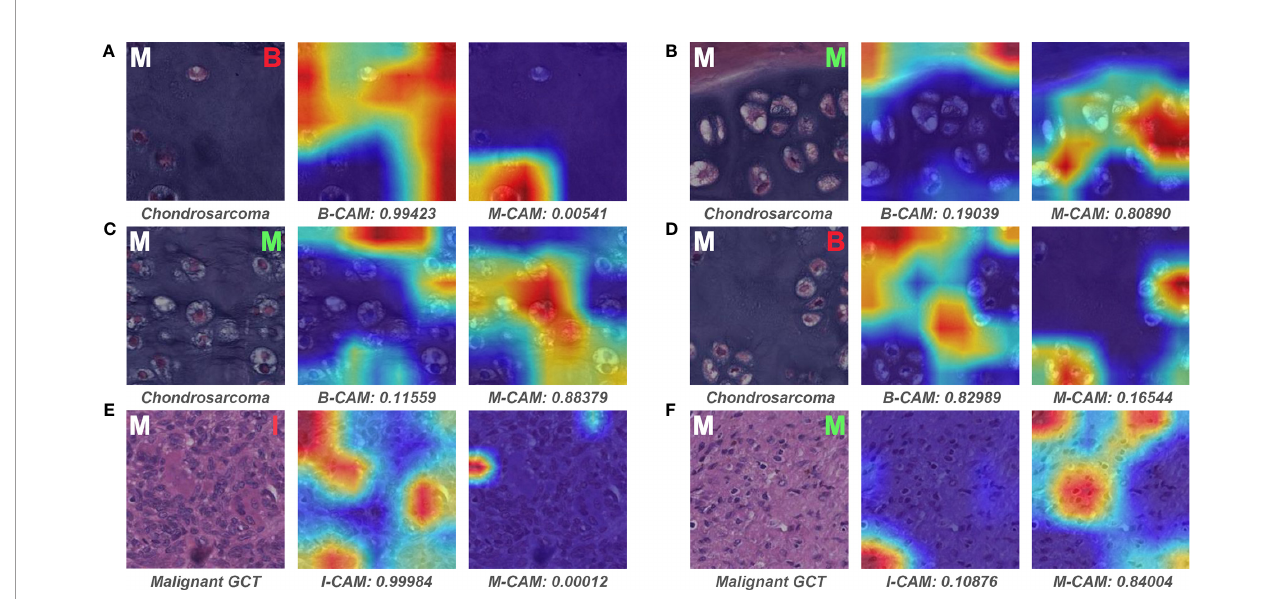
FIGURE 8 | Representative patches of slides wrongly classi fi ed by models and the associated Grad-CAM results. The ground truth label of the original patch is displayed on the upper left in white, and the predictive classi fi cation of the model is presented on the upper right in red (false prediction) or green (correct prediction). The speci fi c classi fi cation is shown under the original patch, and the predictive probability for CAM of each class is shown below the corresponding Grad-CAM heatmap. (A – F) show the representative patches of chondrosarcoma and malignant giant cell tumor, respectively. B, benign; I, intermediate; M, malignant; CAM, class activation mapping; GCT, giant cell tumor.